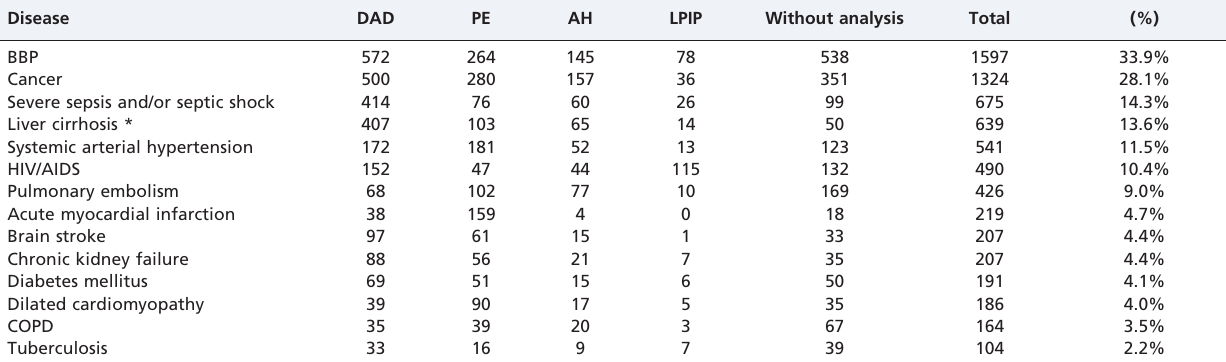
*=No cause identified; DAD=Diffuse alveolar damage; PE=Pulmonary edema; AH=Alveolar hemorrhage; LPIP=Lymphoplasmacytic interstitial pneumonia; BBP=Bacterial bronchopneumonia; HIV/AIDS=Human immunodeficiency virus/acquired immunodeficiency syndrome; COPD=Chronic obstructive pulmonary disease. infarction in 4.7% (219), stroke in 4.4% (207), and tubercu- losis in 2.2% (104 cases) of the patients. The main associated comorbidities were systemic arterial hypertension in 11.5% (541 cases), chronic kidney failure in 4.4% (207), diabetes mellitus in 4.1% (191), dilated cardiomyopathy in 4.0% (186), and chronic obstructive pulmonary disease in 3.5% (164) of the patients.